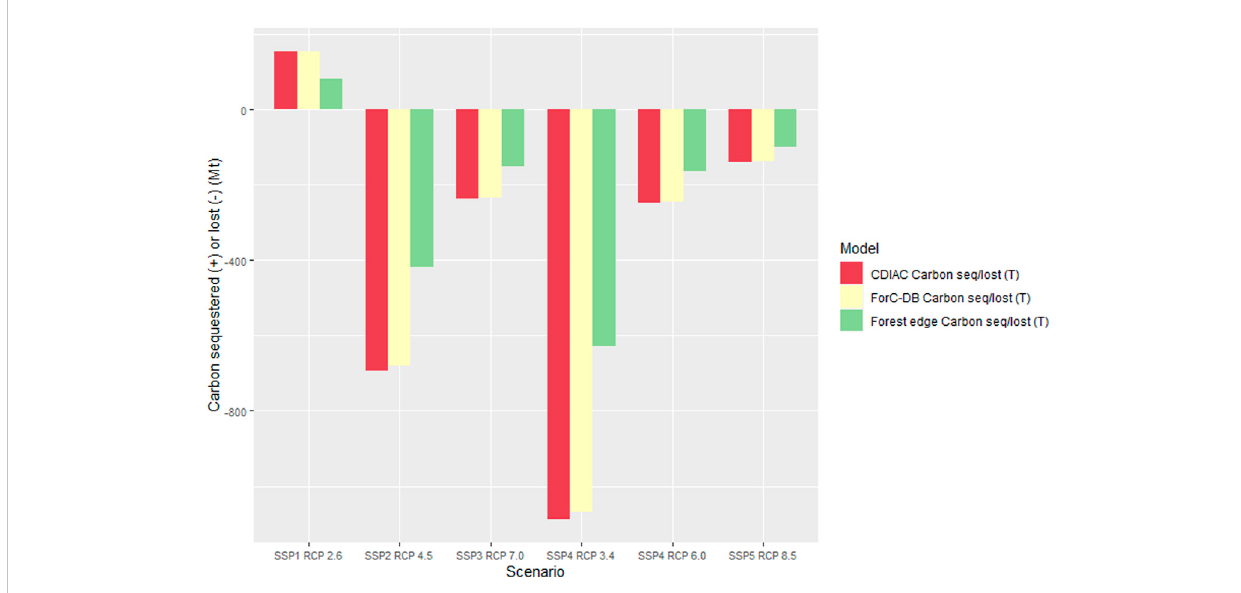
Comparison betweenCDIAC, ForC-DB and Forest edgecarbonpoolsfor the carbonsequestered (positive values) or lost(negative values) between 2015 and 2050 SSP